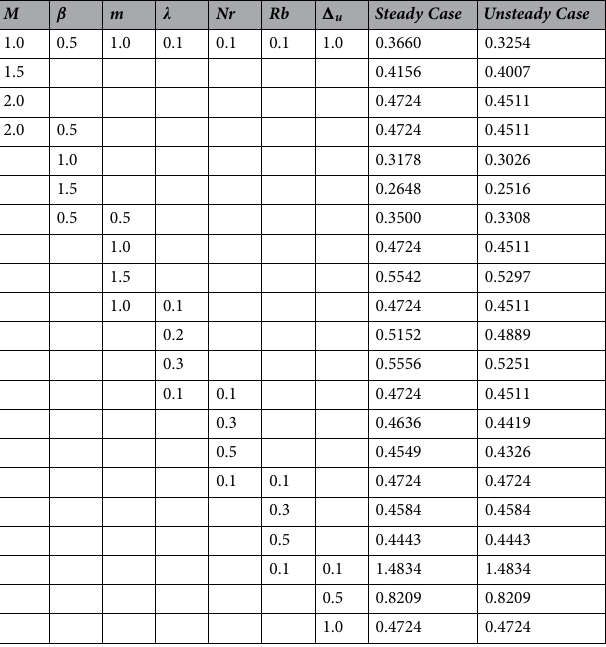
Table 3. Results of skin friction factor – f ′′ ( 0 ) in x-direction for various